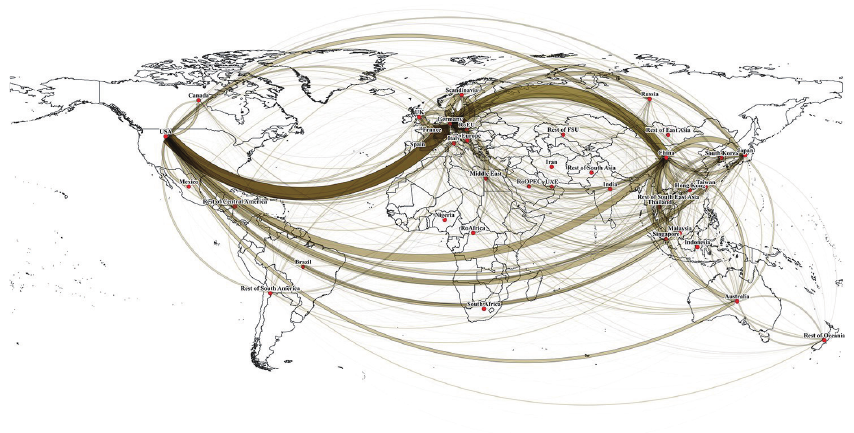
Figure 3. Wage and salary income losses as a consequence of trade volume reductions in international supply chains due to the global COVID-19 effects. The lines connect ultimate origins and destinations of supply chains, both direct and multinode, with line thickness representing the trade volume lost